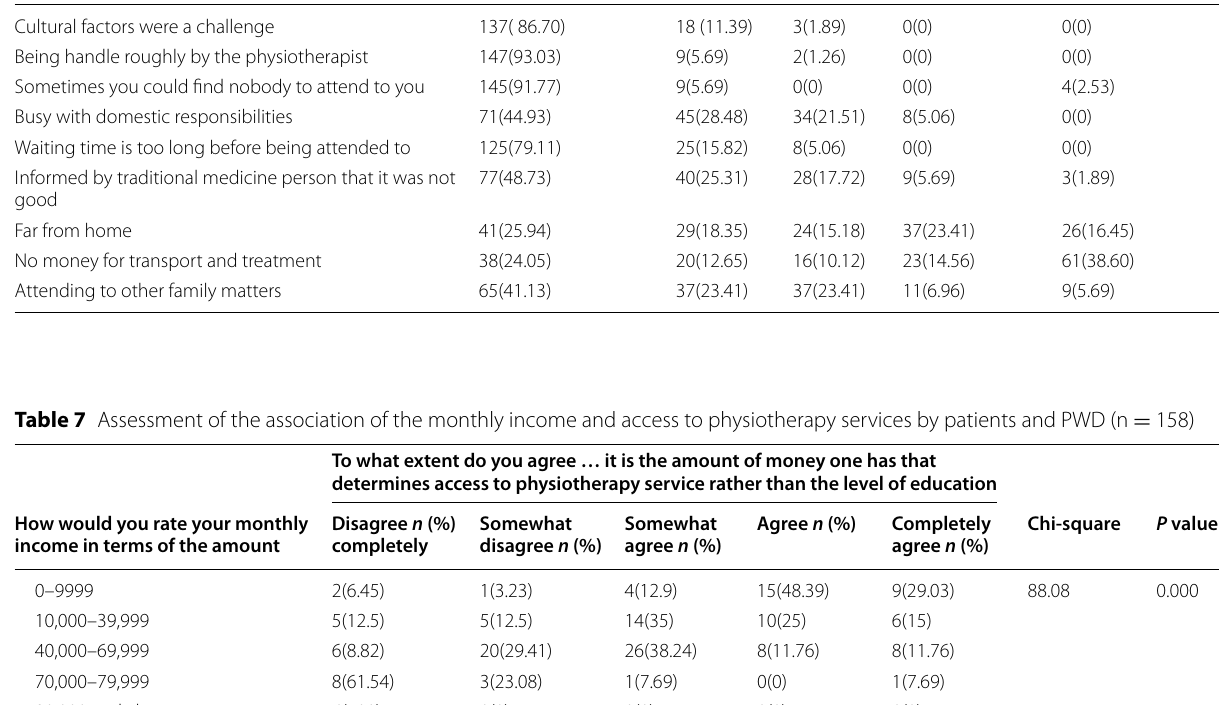
Table 6 Barriers that could lead to failure to attend physiotherapy by patients and PWD ( n Barriers, n (%)